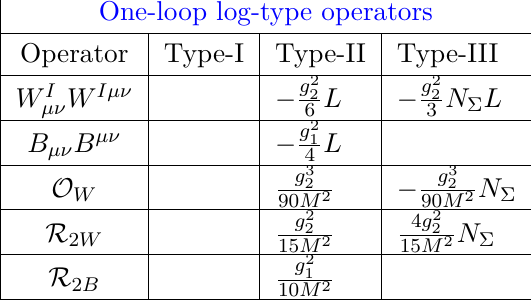
Table 2 . Log-type terms from one-loop matching in the Green’s basis, where N Σ counts the number of flavors for Σ , which we take to be 3 for our numerical study. We define L ≡ log (cid:0) µ 2 convenience. For matching at one loop, we always leave the factor 1 / (16 π 2 ) implicit in the Wilson coefficients. The specific forms of the dimension-6 operators are listed in table 13.